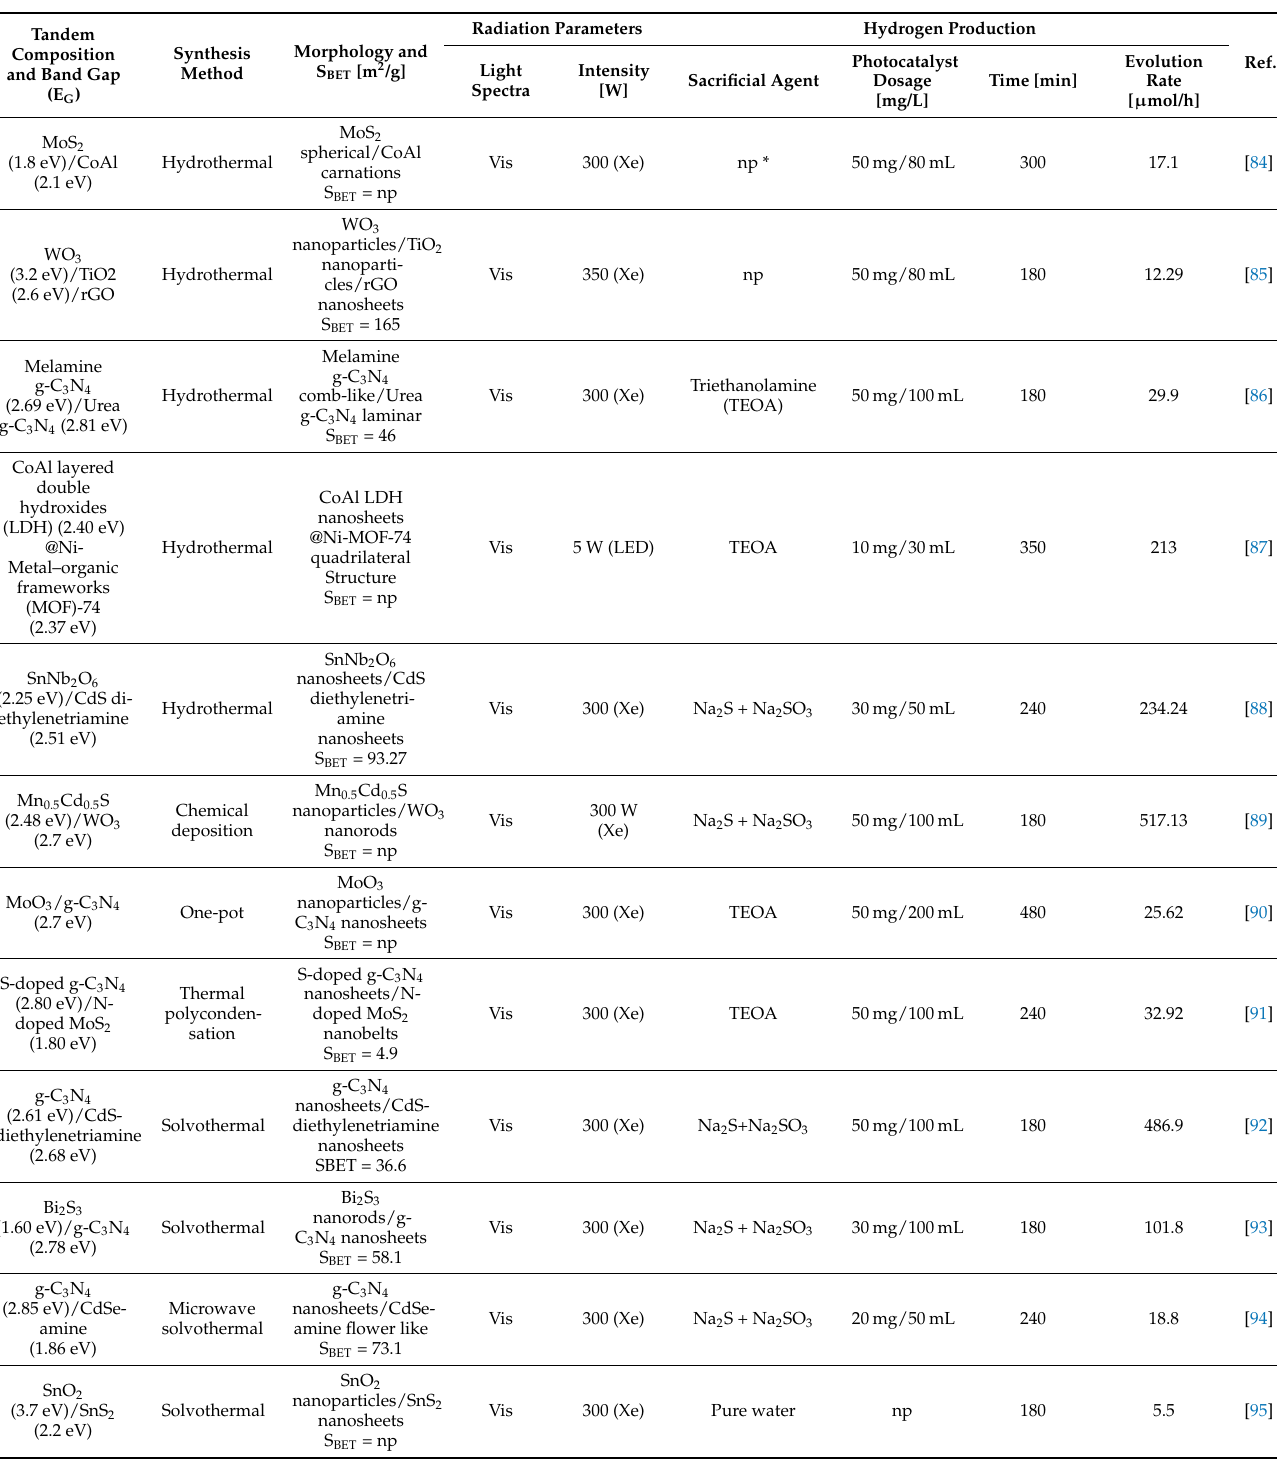
photocatayst dosage. The combined effect of the S-scheme heterostructure, formed between semiconductors metal oxides, and the Schottky heterojunction, formed between TiO 2 and graphene sheets, is able to suppress the recombination of useful photogenerated carriers and increase the number of active surface sites for the reduction reaction. Table 2. Recent representative studies on the use of S-scheme heterojunction for organic pollutant removal. Tandem